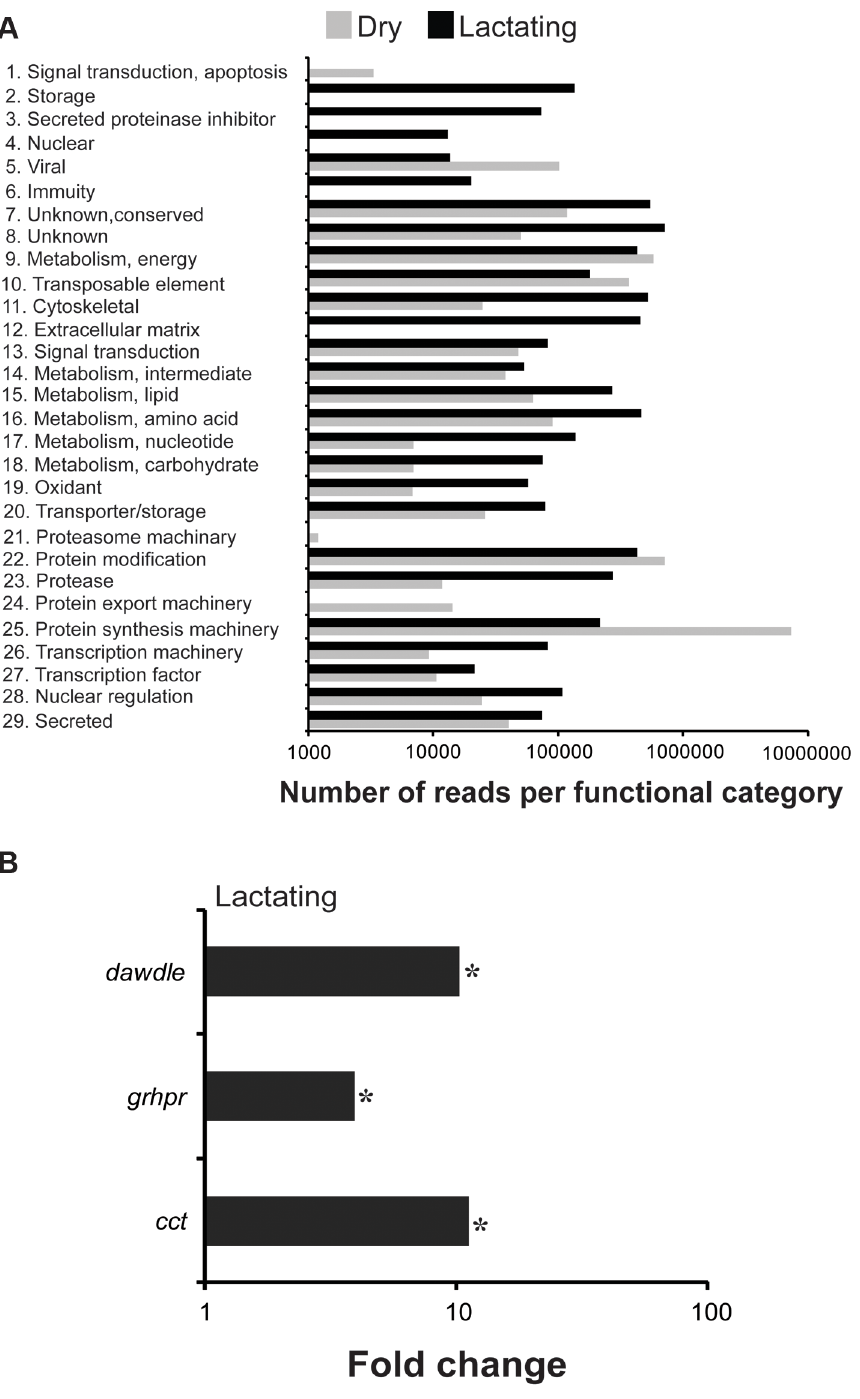
Figure 5. GO enrichment and genes identified following RNA-seq analysis after milk-specific gene removal. (A) Reads in dry and lactating flies that mapped to genes with specific metabolic function. *, indicating a significantly higher level in lactating flies based on chi-square test. (B) Select genes identified as increased during lactation following RNA-seq analysis after milk-specific gene removal. *, indicates significantly different between lactating and dry flies based on Kal’s test followed by Bonferroni